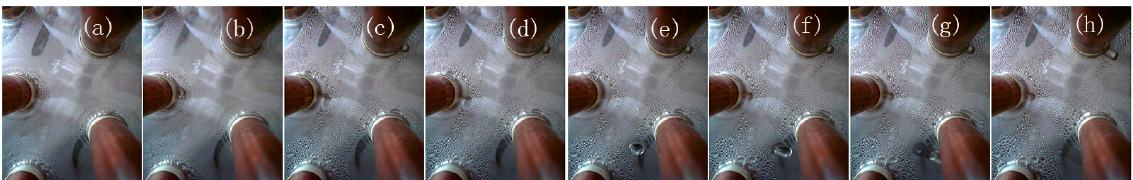
Figure 5. Condensate droplets on the aluminum fin surface: ( a ) τ = 10 s, ( b ) τ = 60 s, ( c ) τ = 120 s, ( d ) τ = 160 s, ( e ) τ = 200 s, ( f ) τ = 230 s, ( g ) τ = 260 s, ( h ) τ = 290 s.